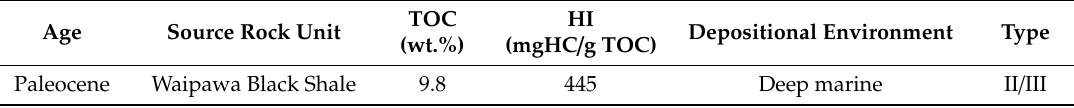
Table 3. Parameters of the source rock used as an input data for the model (from Johasen